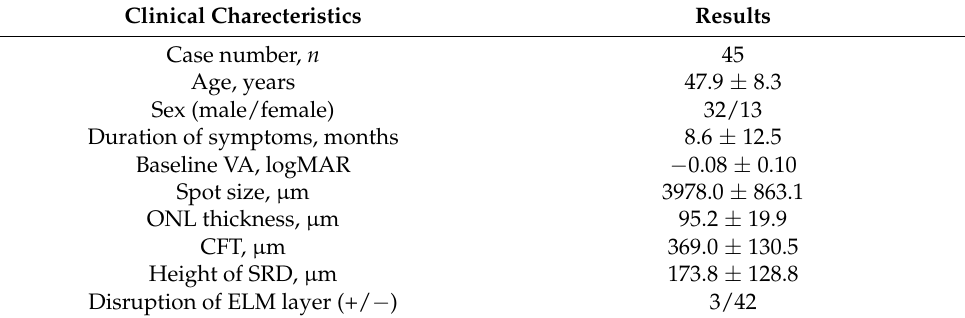
Table 1. Clinical